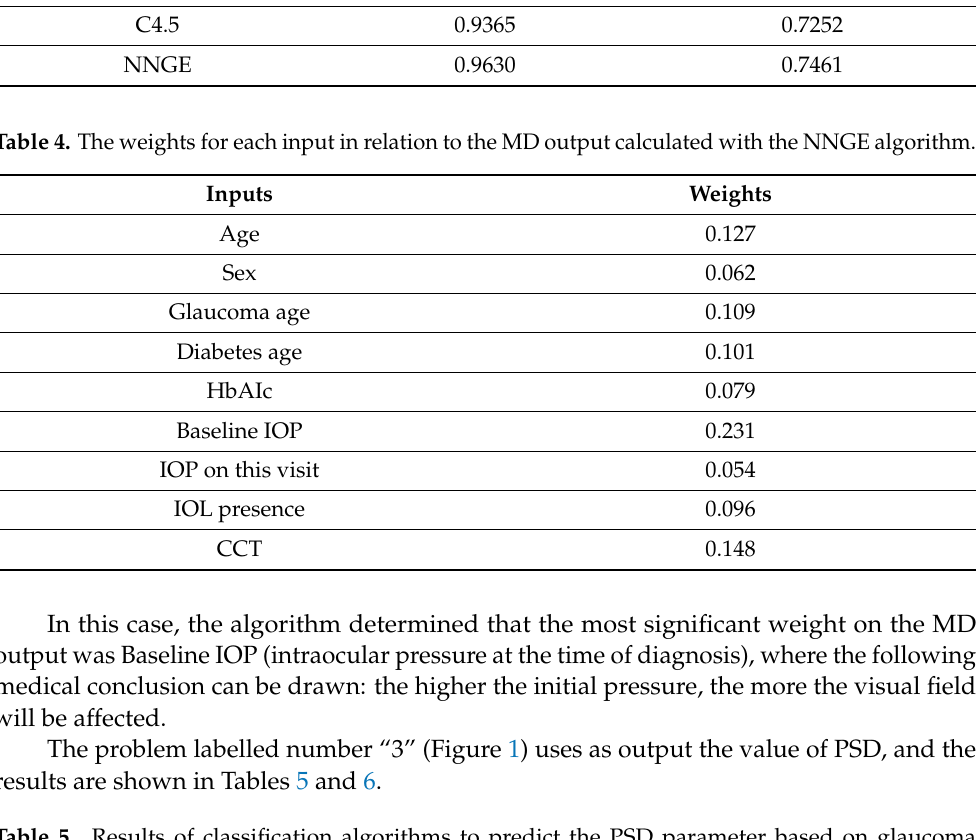
Table 5. Results of classification algorithms to predict the PSD parameter based on glaucoma risk